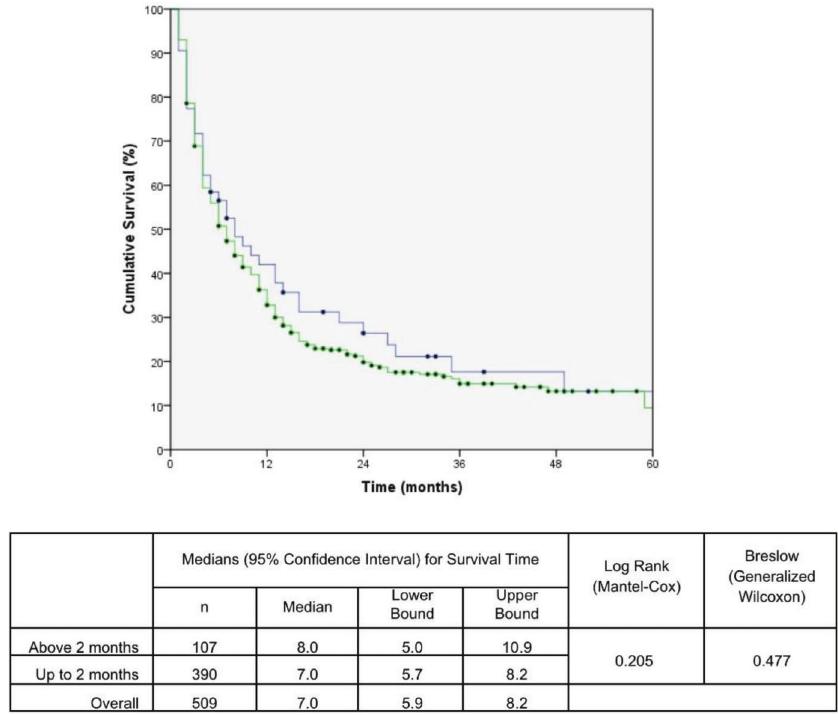
Figure 2 - Kaplan Meier curve for mortality due to lung cancer in patients according to time from the appointment (first app) to diagnosis (DX). The blue line represents the patients diagnosed up to 2 months and green line above 2 months.